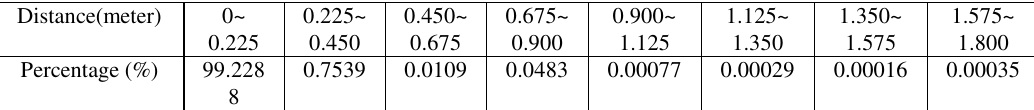
Table 2. Distribution of point-to-plane distance of the compared point